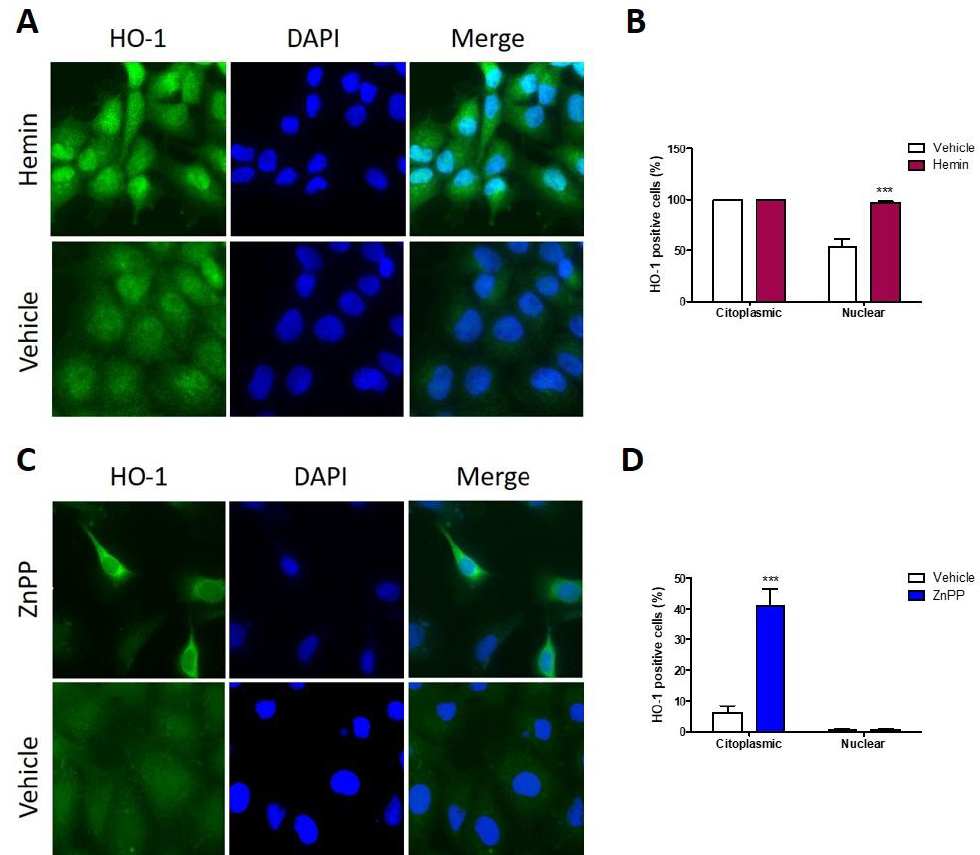
Figure 5. HO-1 subcellular localization in HN13 cells following pharmacological modulation. Representative images of HO-1 expression in HN13 cells after treatment with ( A ) 80 uM hemin or its vehicle for 24 h. ( B ) Semi-quantification of nuclear HO-1-expressing and cytoplasmic HO-1-expressing cells after hemin treatment. ( C ) Representative images of HO-1 localization in HN13 cells after treatment with 10 uM ZnPP or its vehicle for 24 h. DAPI was used to stain nucleus. ( D ) Semi-quantification of nuclear HO-1-expressing and cytoplasmic HO-1-expressing cells after ZnPP treatment. *** p < 0.001 respect to vehicle.